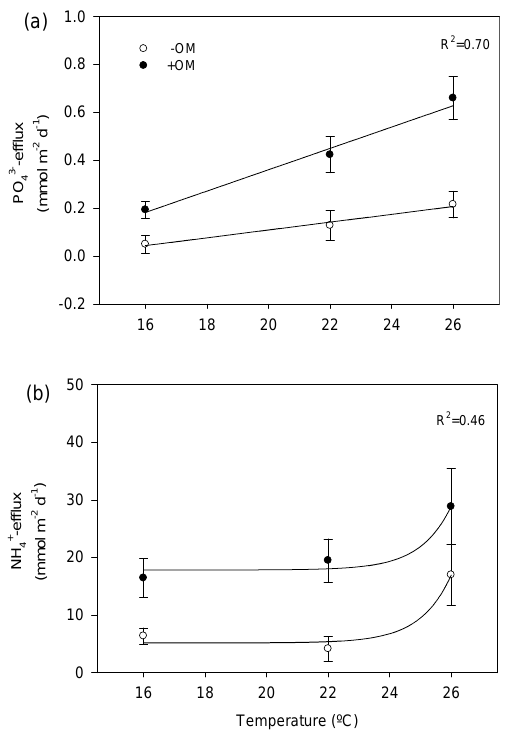
Figure 3. Nutrient sediment–water-column flux rates ( n = 6, mean ± SE) versus temperature under nonorganically ( − OM) and or- ganically polluted ( + OM) conditions. Lines indicate significant ( p <0.05) regressions for − OM and + OM treatments. Type of re- gression was chosen according to the AICc (corrected Akaike in- formation criterion; Table A1). R 2 refers to the whole regression model for each nutrient, which includes the factor